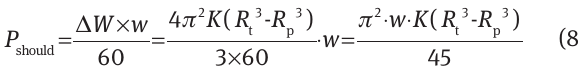
The multiplication model on the bottom area of the pin is shown in Figure 6. The heat-flow density into the workpiece between the bottom of the pin and the work- piece is p